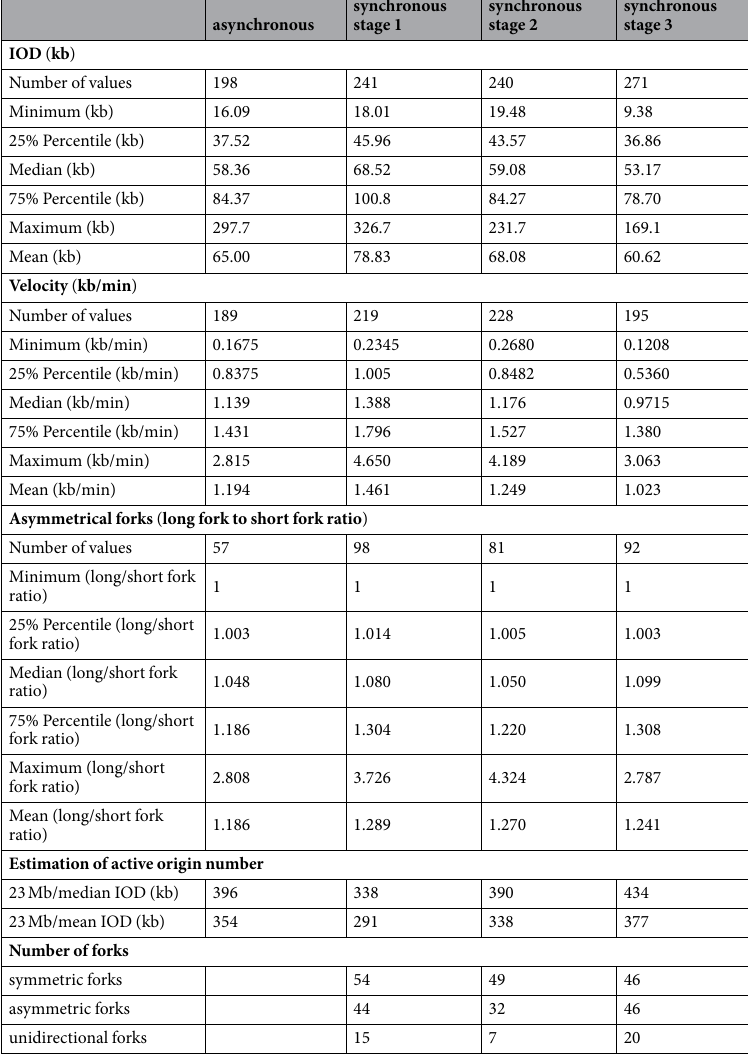
Table 1. DNA replication parameters (column statistics) in asynchronous blood-stage parasites and in synchronous parasites at Stages